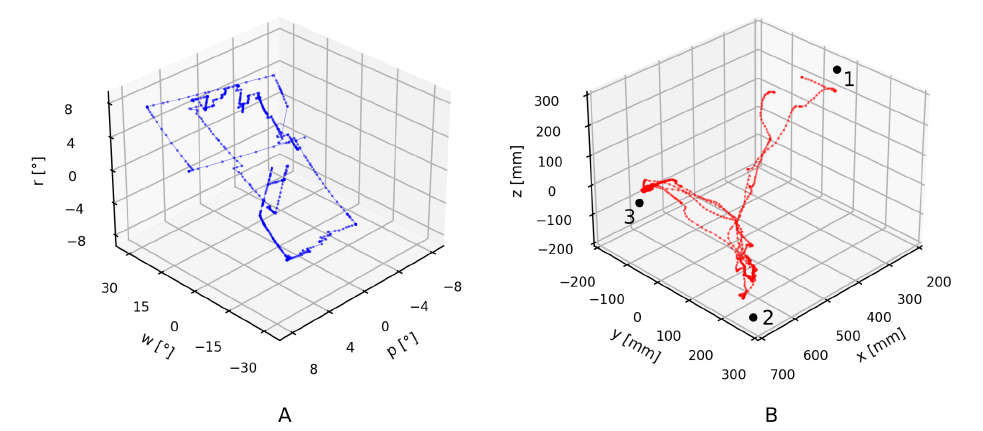
Figure 9. ( A ) Rotation of the robot’s end effector, and ( B ) its translation while the evaluation task was performed with the developed IMU